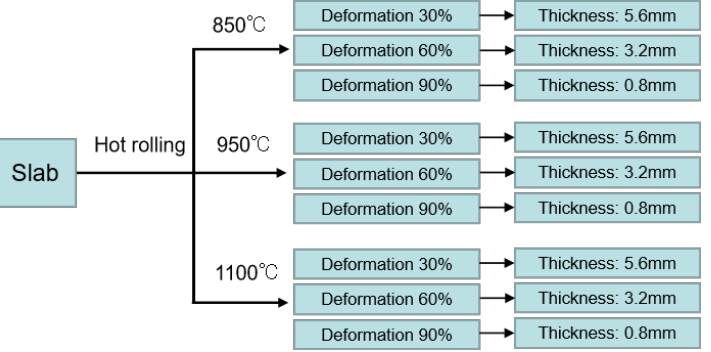
Figure 2. Rolling scheme of Ti-6Al-4V alloy ingot.